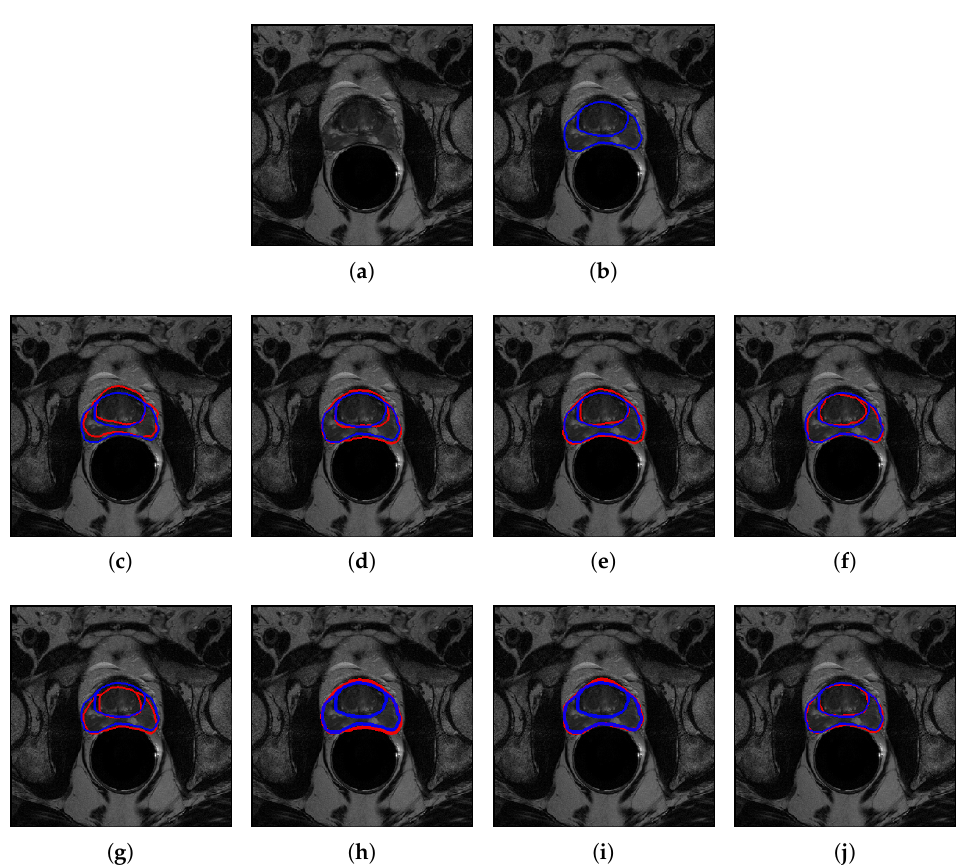
Figure 6. Segmentation of prostate T2W MRI, from NCI-ISBI 2013 dataset into PZ and CG regions. ( a ) Original image, ( b ) ground truth boundary, where predicted boundary (red), overlay on the ground truth (blue), based on the method without patch extraction using, ( c ) FCN, ( d ) SegNet, ( e ) U-Net and ( f ) DeepLabV3+, and based on patch extraction using ( g ) FCN, ( h ) SegNet ( i ) U-Net and ( j )